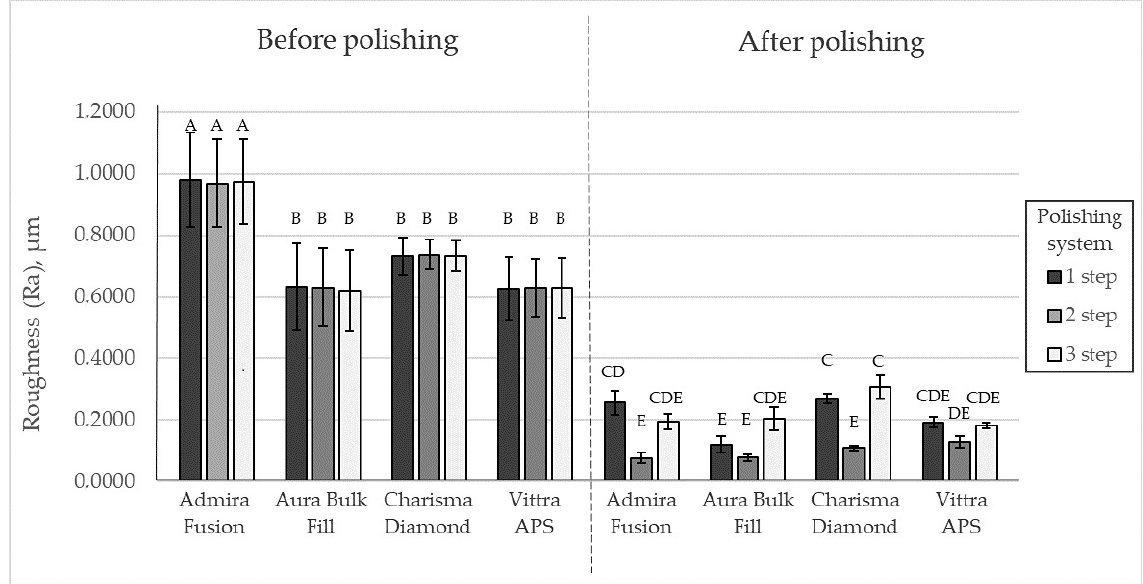
Figure 2. Mean surface roughness (Ra, µm), standard deviations and results of the Tukey test for each subgroup *. * Different letters indicate statistical differences between the subgroups. Table 3. Mean ± standard deviation for surface roughness (Ra in µm) before and after polishing according to the composite resin and polishing system.